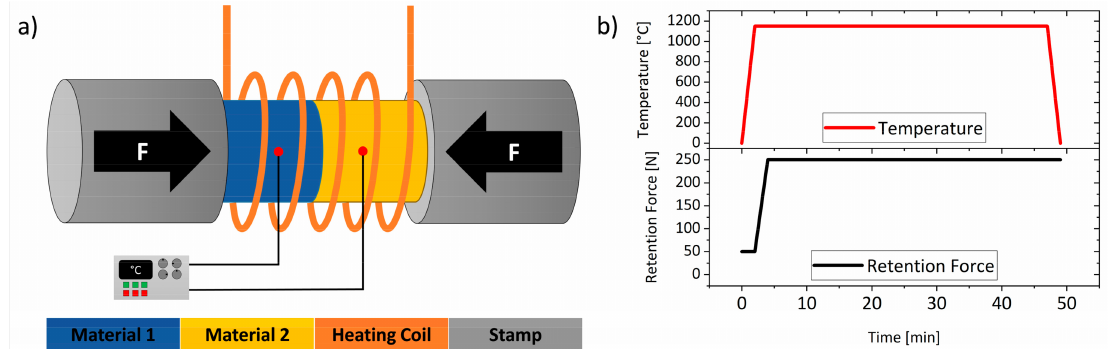
Figure 1. Schematic illustration of the di ff usion bonding process in a deformation dilatometer: ( a ) Two cylindrical samples are fitted with thermocouples and placed between two stamps. The samples are di ff usion bonded by simultaneous annealing at high temperatures and applying mechanical pressure on them, ( b ) Temperature and retention force during the di ff usion bonding